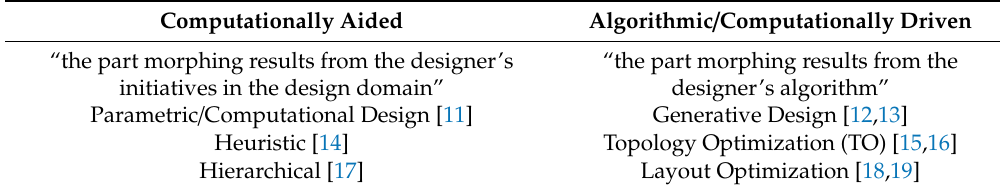
Table 1. Categorization of existing design schools and methods.